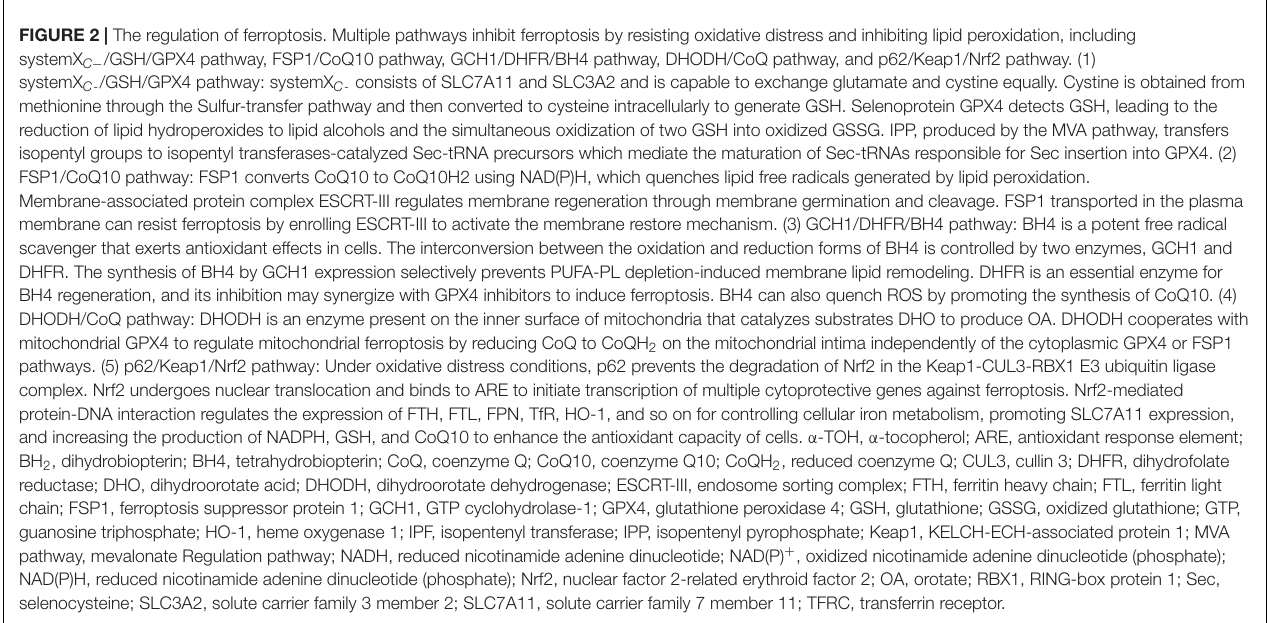
Frontiers in Aging Neuroscience |